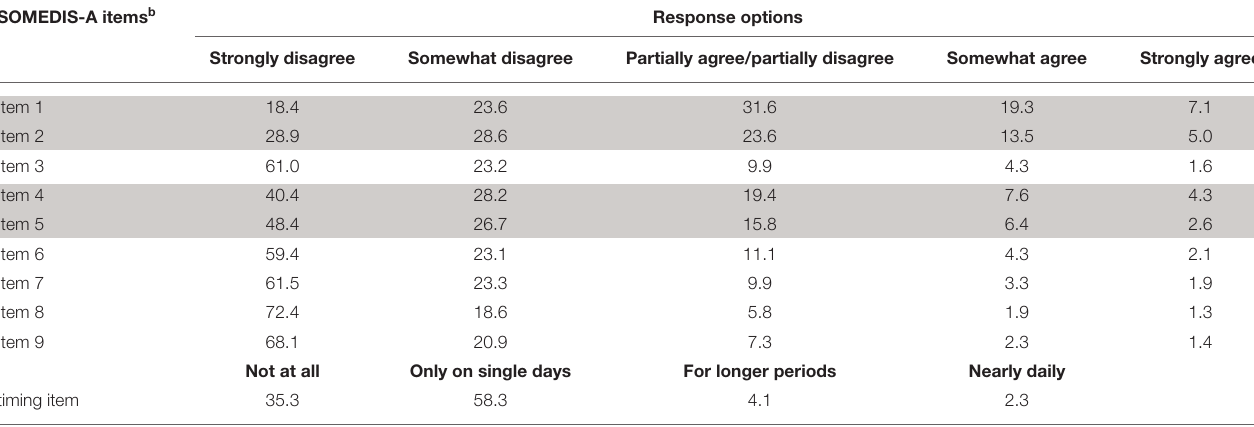
TABLE 5 | Relative item-response frequency of SOMEDIS-A items (in %) a . SOMEDIS-A items b